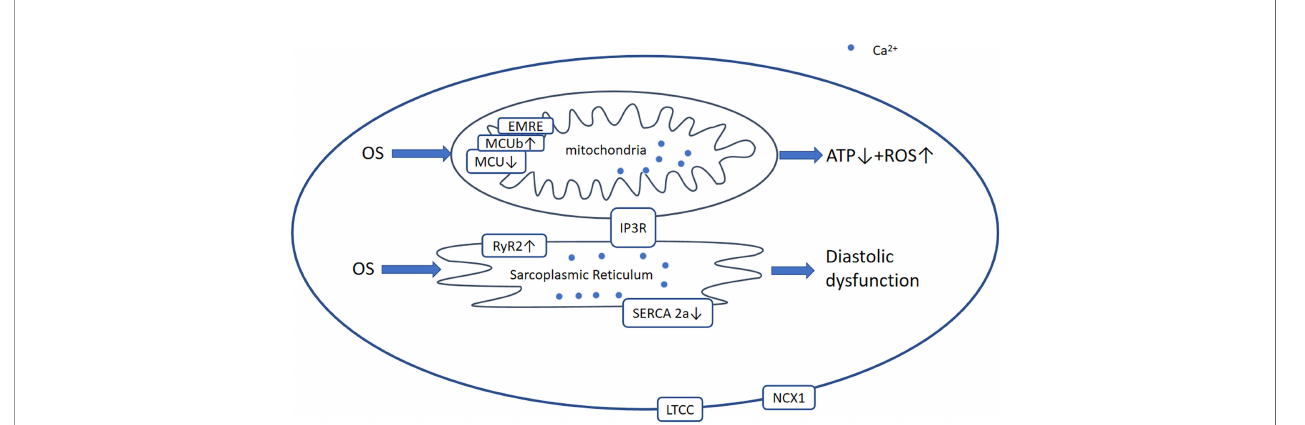
FIGURE 6 | Ca 2+ -dependent signaling pathway. Generally, in DCM, OS leads to the modi fi cation and activation of RyR2 and Ca 2+ leakage from the SR and reduced activation of SERCA2a and MCU. Therefore, [Ca 2+ ] SR and [Ca 2+ ] mito are decreased, which results in diastolic and mitochondrial dysfunction including ROS overproduction and a reduction in ATP production. OS, oxidative stress; RyR2, ryanodine receptor 2; AGEs, advanced glycation end-products; ROS, reactive oxygen species; LTCC, L ‐ type Ca 2+ channel; NCX1, Na/Ca+2+-exchanger-1; MCU, mitochondrial Ca 2+ uniporter complex; EMRE, essential mitochondrial calcium uniporter regulator; IP3R, inositol 1,4,5-triphate